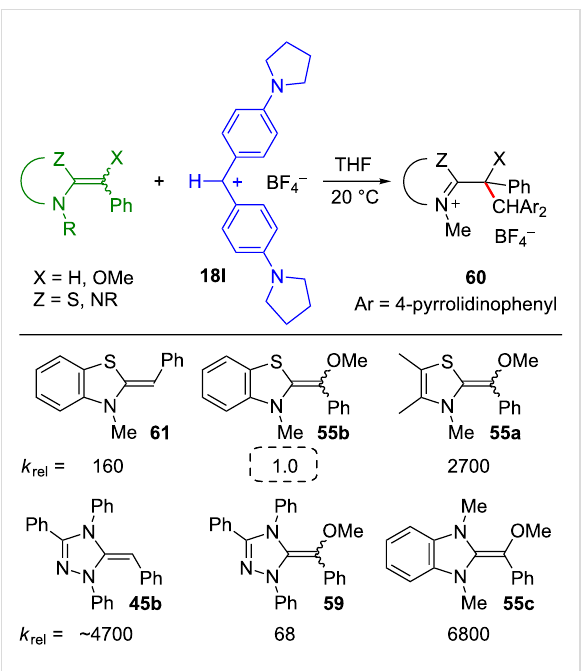
Figure 28: Relative reactivities of deoxy- and O-methylated Breslow intermediates